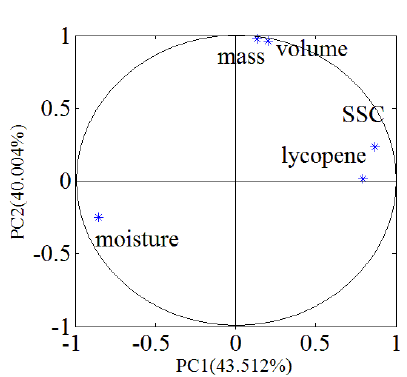
Fig. 9. The plot of rotated component matrix.